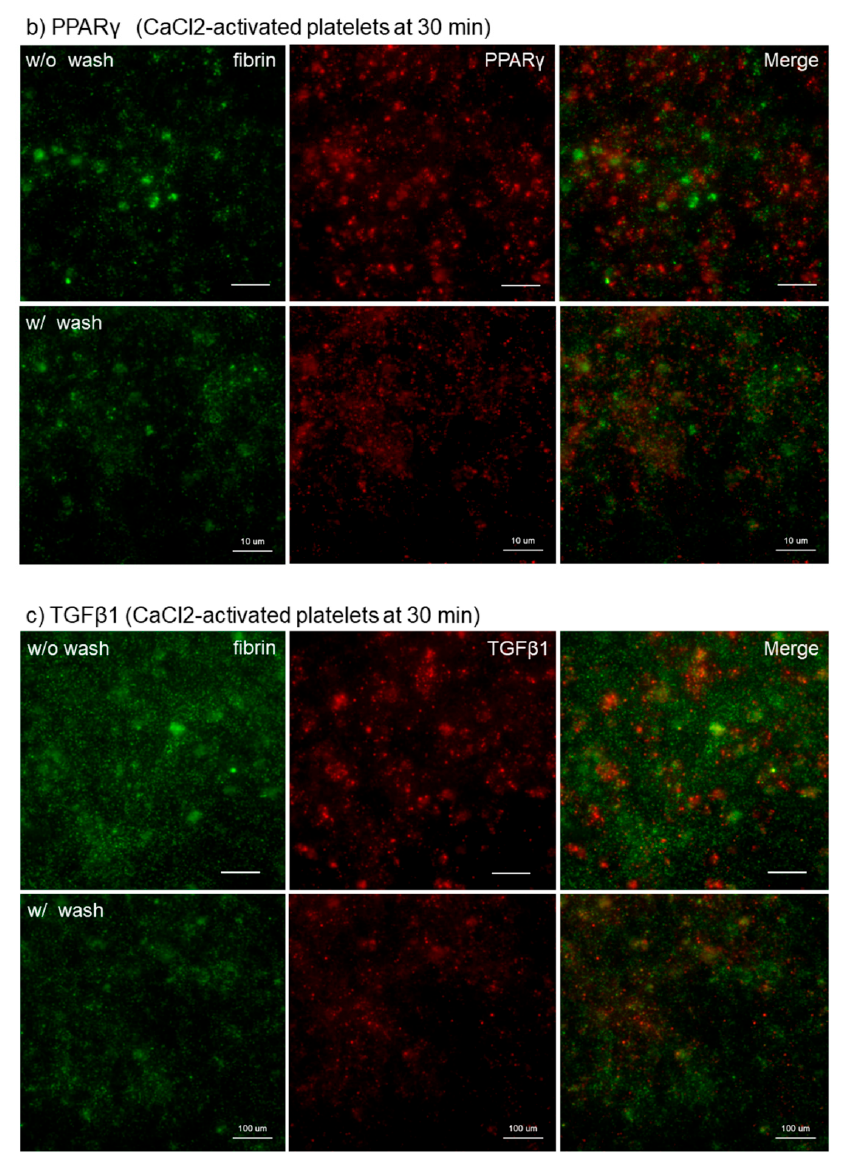
Figure 4. ( a ) Effects of activation with CaCl 2 on microparticle release and ( b , c ) effects of intensive washing on the levels of fibrin formed on and around platelets. ( a ) Platelets suspended in PBS were activated by 0.1% CaCl 2 , incubated on the filter for 10 min, fixed with glutaraldehyde, and subjected to SEM examination. ( b , c ) As described in the legend of Figure 3, activated platelets were fixed with or without intensive washing and ( b , c ) Activated platelets (CD62P; green), ( b ) PPAR γ (red), and ( c ) TGF β 1 (red) were visualized by immunofluorescence. Similar findings were obtained from the samples prepared from the other three donors. Bar = 10 μ m.